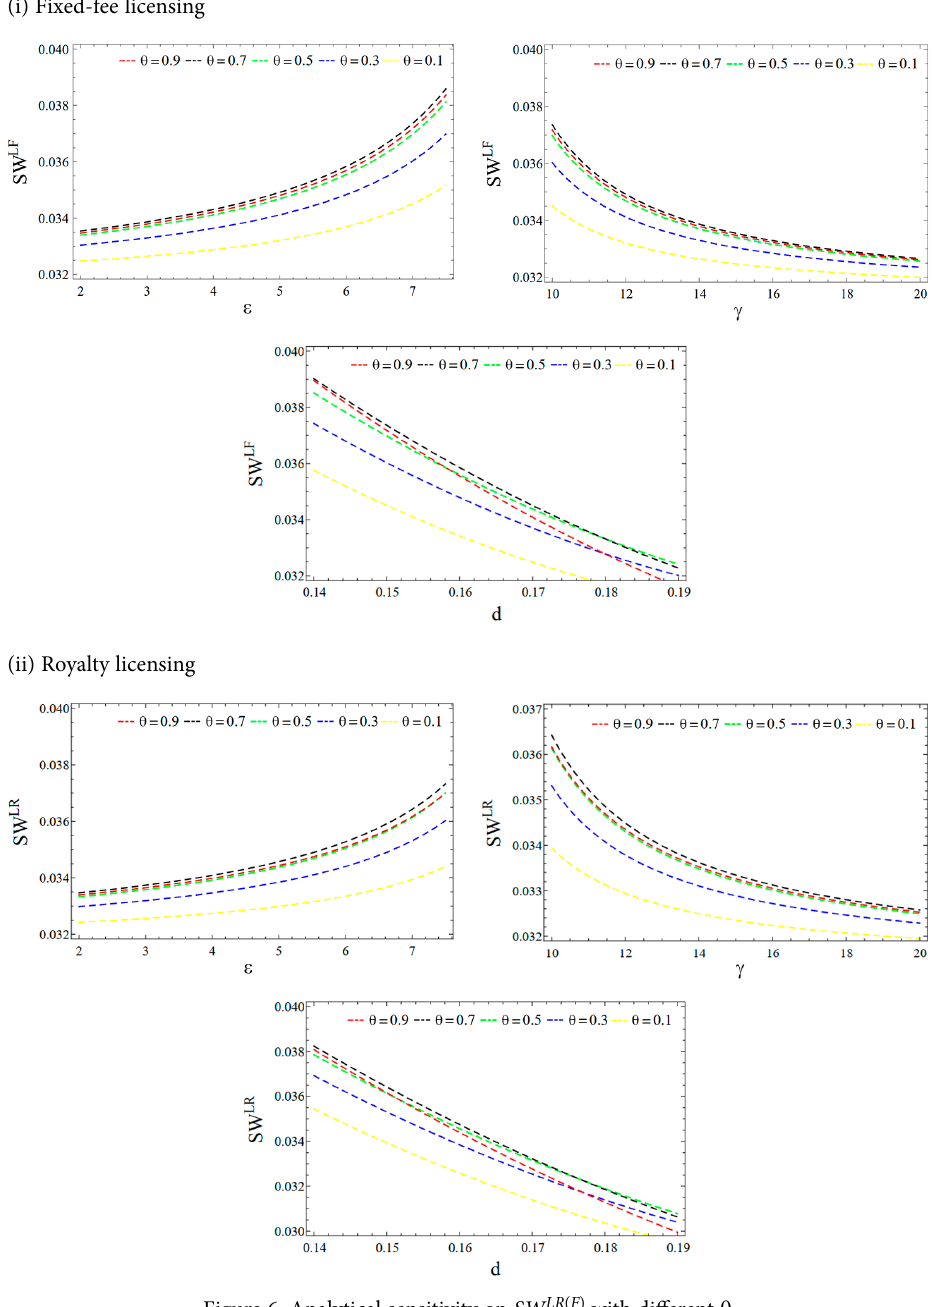
Figure 6. Analytical sensitivity on SW LR ( F ) with different